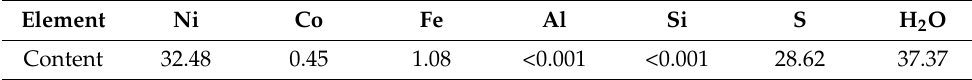
Table 1. Analysis results of the NiS and CoS mixed materials